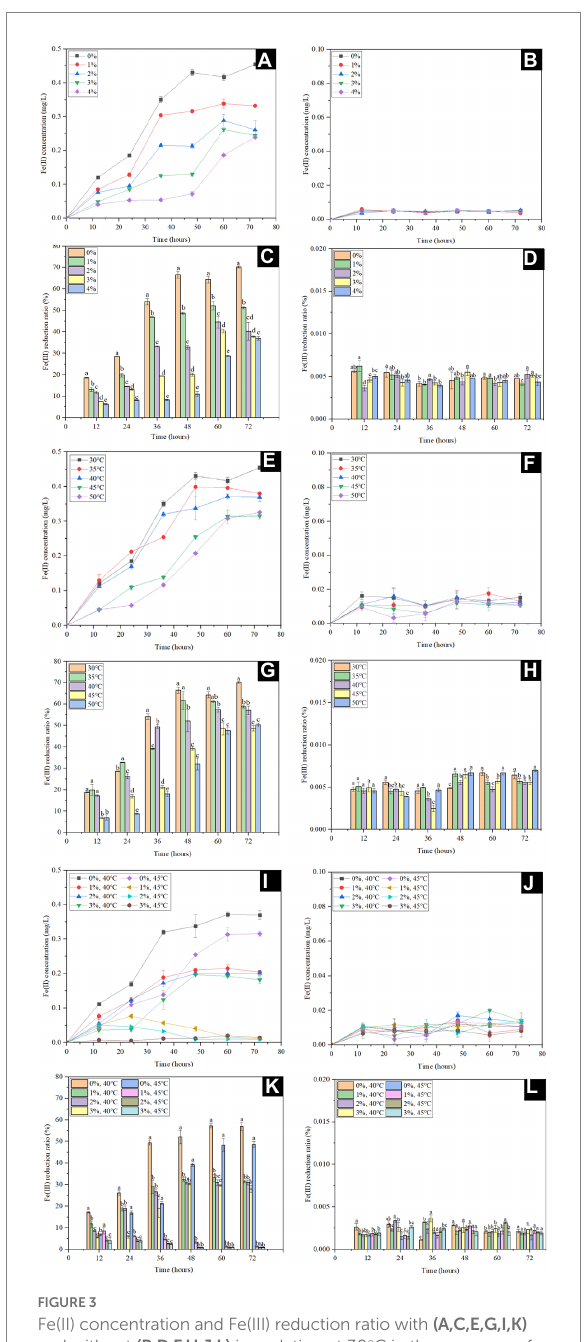
FIGURE 3 Fe(II) concentration and Fe(III) reduction ratio with (A,C,E,G,I,K) and without (B,D,F,H,J,L) inoculation at 30 ° C in the presence of different NaCl concentrations (0, 1, 2, 3 and 4% w/v) (A,B,C,D) , different temperatures (30 ° C, 35 ° C, 40 ° C, 45 ° C, and 50 ° C) in the absence of NaCl (E,F,G,H) , 40 ° C and 45 ° C in the presence of different NaCl concentrations (0, 1, 2 and 3% w/v) at (I,J,K,L)